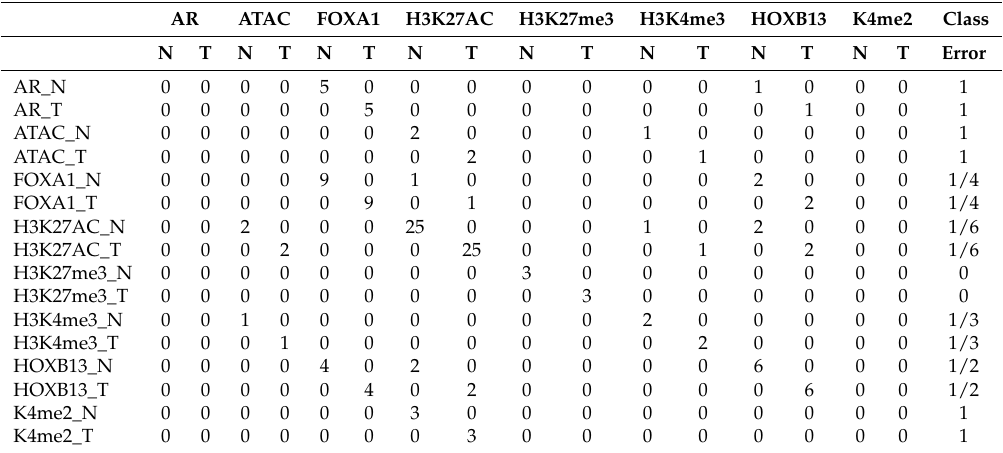
Table 8. Confusion matrix for LDA using u 1 j u 2 k u 3 m given by TD applied to 1447 genomic regions selected by TD-based unsupervised FE applied to the real dataset. N: normal prostate, T: tumor. The error rate is